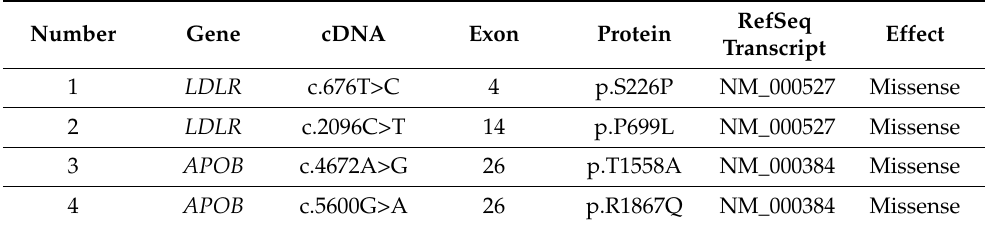
Table 1. Rare genetic variants found in the cohort by LDLR , APOB , and PCSK9 gene